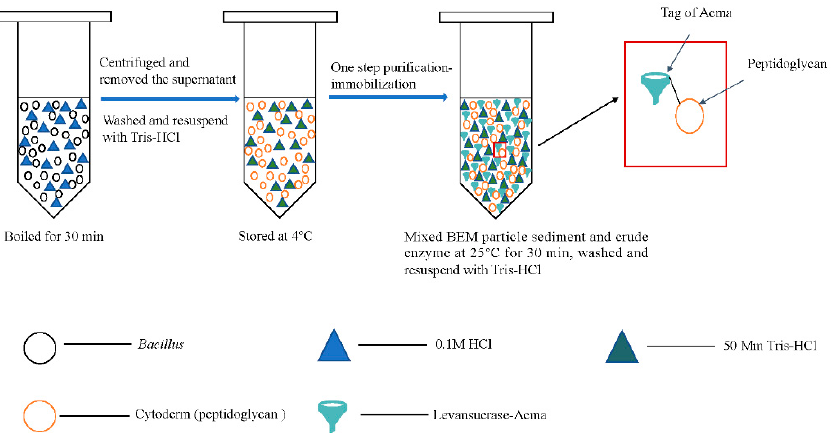
Figure 3. Illustration of bacterial enhancer matrix (BEM) particles one-step immobilization-purifi- cation.